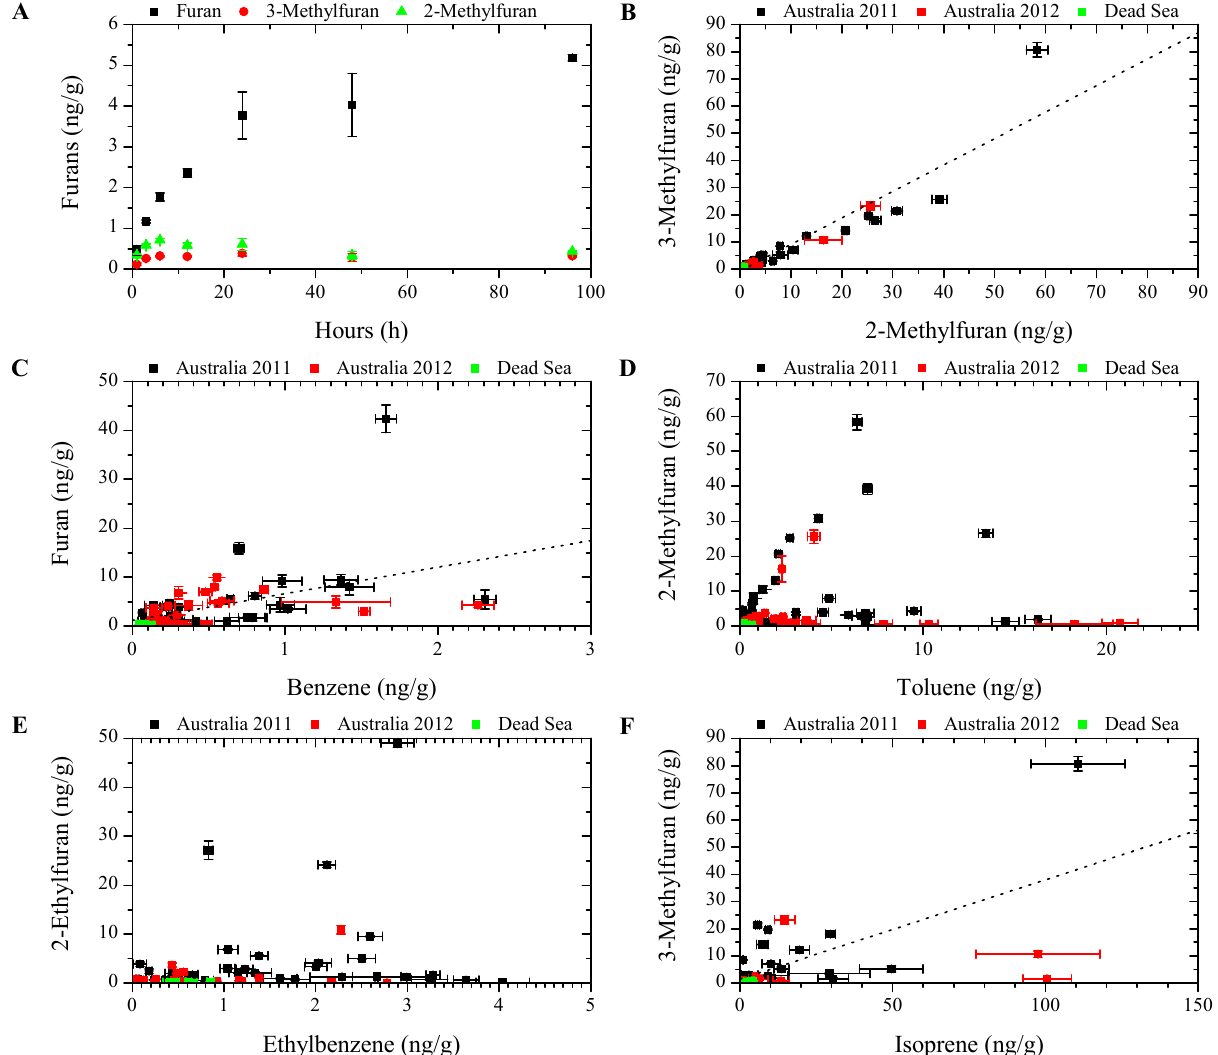
Figure 6. (A) Temporal distribution of the furan (black), 2-methylfuran (green) and 3-methylfuran (red) from Lake Boats sample (0–2cm). Correlation between (B) 2-methylfuran and 3-methylfuran emissions, (C) furan and benzene, (D) 2-methylfuran and toluene, (E) 2-ethylfuran and ethylbenzene and (F) 3-methylfuran and isoprene from sediment samples (Australia 2011: black; Australia 2012: red; Dead Sea 2012: blue). Data points represent mean values with error bars indicating standard deviations from triplicate